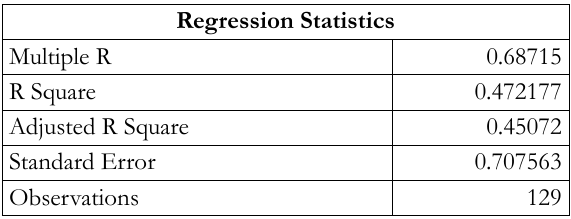
Table 11. Regression statistics on sensitizations and training against increased usage of ICTs ANOVA df SS MS F